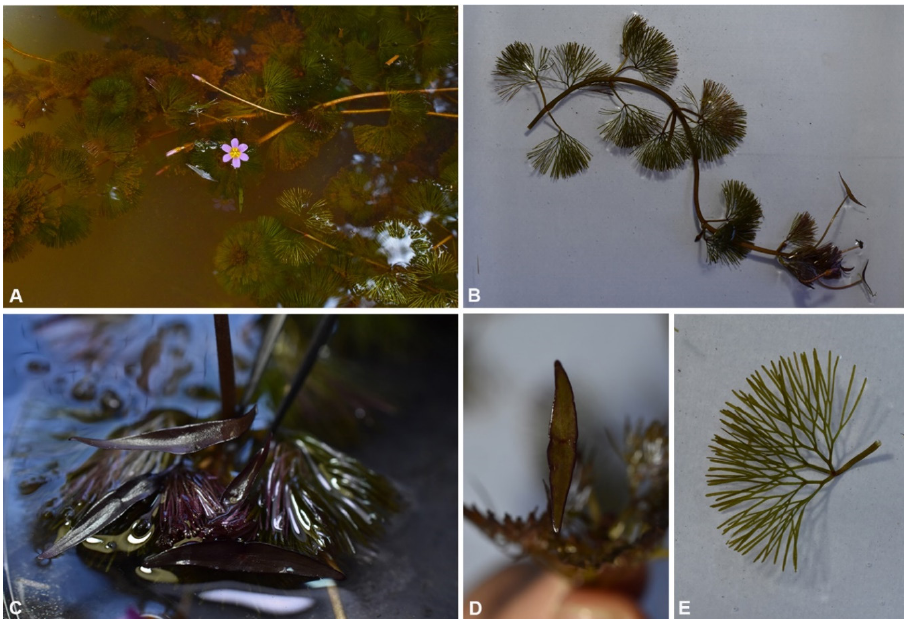
Figure 1: Vegetative habit of Cabomba furcata . A. Submerged plant floating just below the water surface, note the submerged filiform leaves and the floating leaves peltate together with the flower; B. Plant mounted in water, note the submerged filiform leaves in whorls of three; Peltate floating leaves towards the apex where the apical internodes are very short; C. and D. Peltate floating leaves, and E. Submerged filiform leaves.